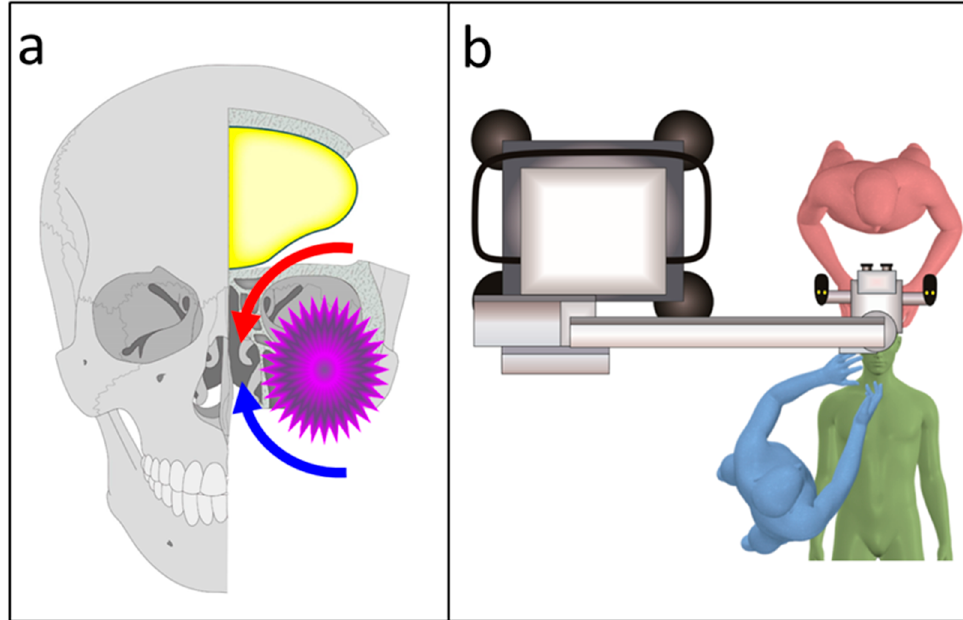
Figure 1. Schematic diagrams of craniofacial resection (CFR). ( a ) CFR combines both the transcranial (red) and transfacial (blue) approaches. ( b ) the transfacial approach is performed by head and neck surgeons (blue), whereas the transcranial approach is performed by neurosurgeons (red). Before 2019, a microscope was used during the transcranial approach of CFR. Green: patient.